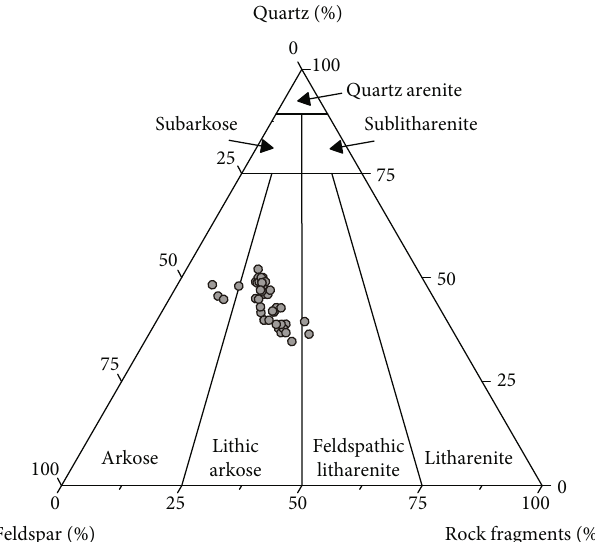
Figure 3: Rock composition of the beach-bar sandstones in the Boxing Sag. Based on the classi fi cation standard of Folk et al.